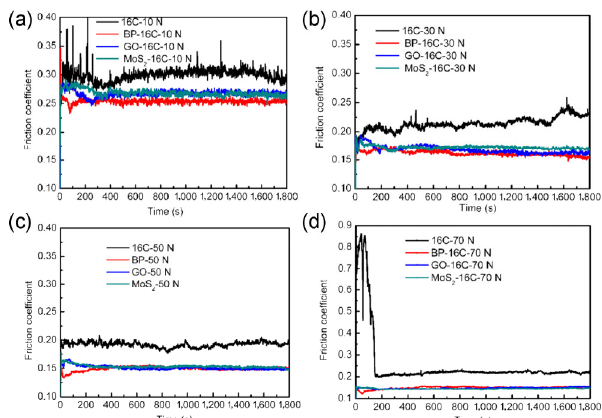
Fig. 11 The coefficient of friction of three dispersion at lower load (16C is the hexadecane, BP-16C: BP nanosheets were dis- persed in hexadecane, GO-16C: graphene oxide were dispersed in hexadecane, MoS 2 -16C: MoS 2 nanosheets were dispersed in hexadecane).